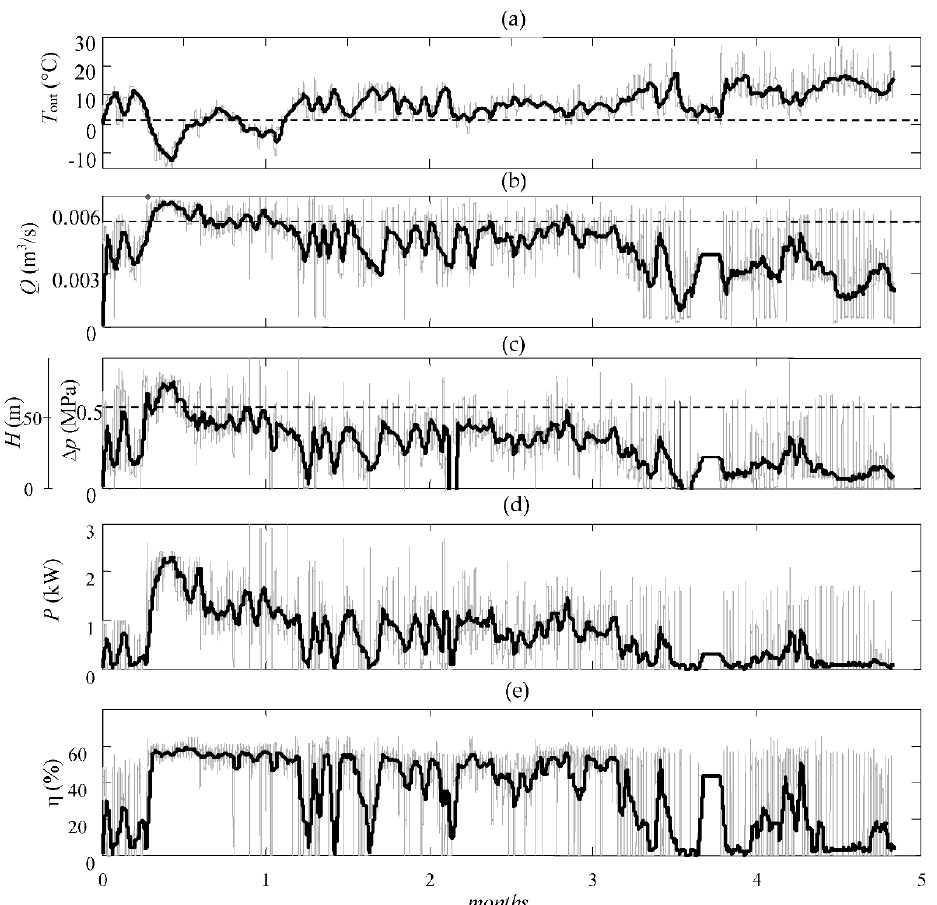
Figure 15. Curves of: ( a ) outside temperature; ( b ) flow rate; ( c ) reduced pressure; ( d ) electrical active power; and ( e ) total ERPR efficiency during the 5 months of heating season (from December to April) in the Cracow DHS substation.